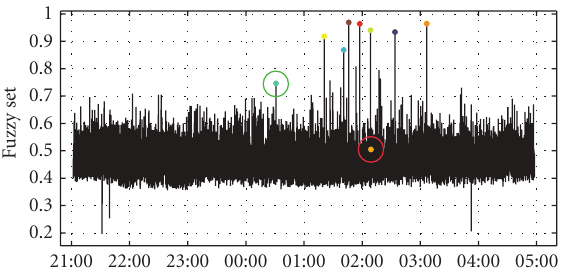
Figure 9: Time series of the Fuzzy set F